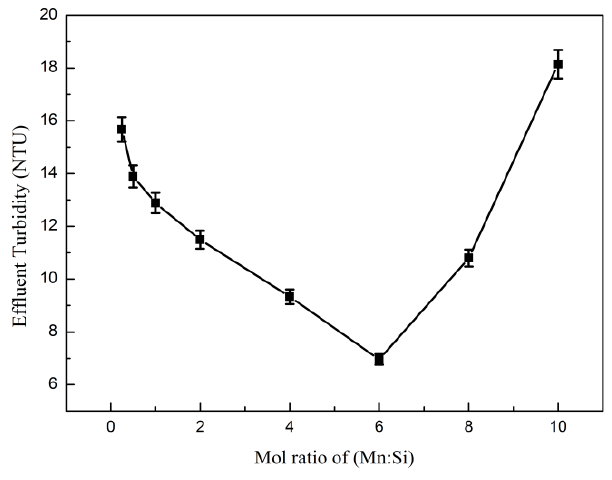
Figure 5. Effect of nMn:nSi on Mn-PSAFS removal of turbidity.